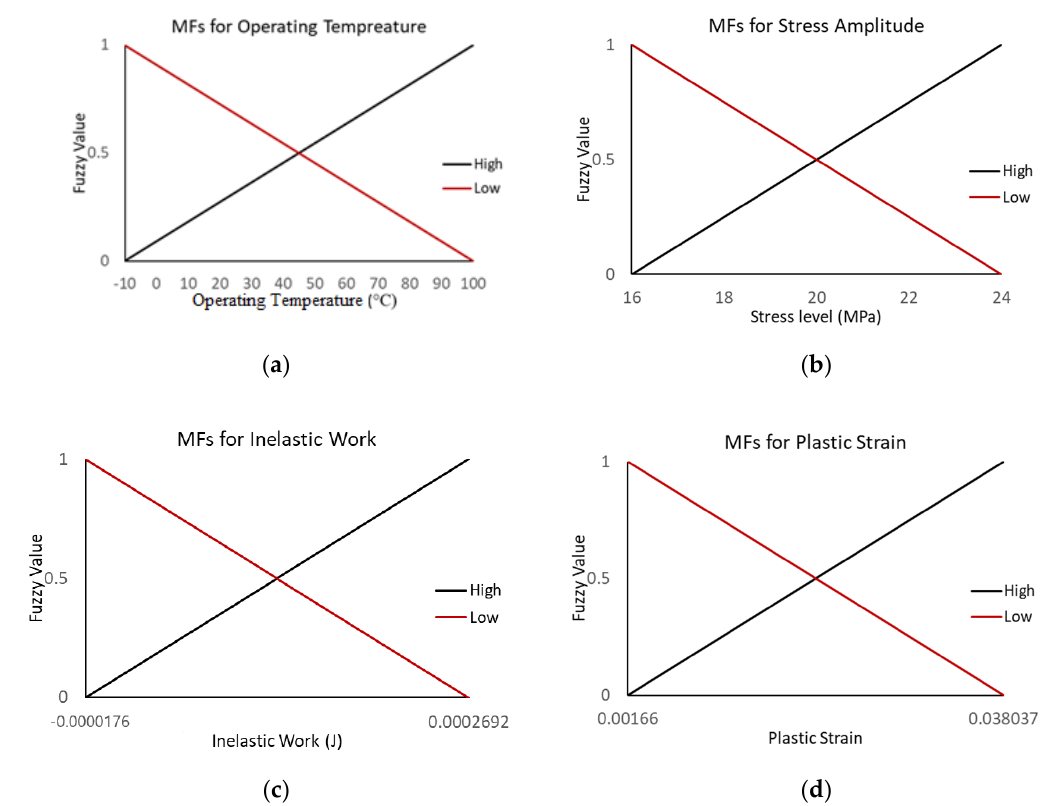
Figure 9. Inputs MFs for ( a ) operating temperature, ( b ) stress level, ( c ) inelastic work, ( d ) plastic strain).